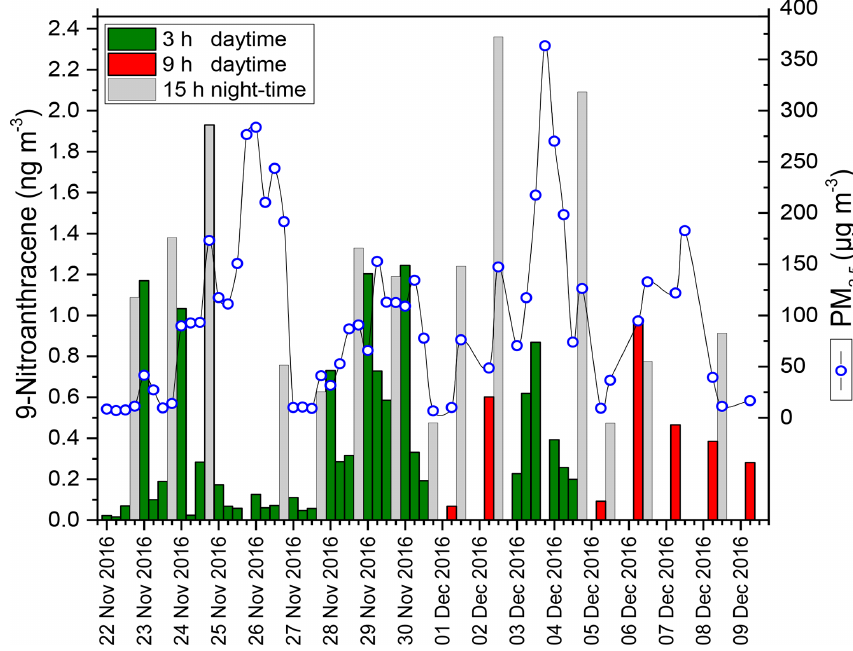
Figure 6. Temporal variation of 9-nitroanthracene and PM 2 . 5 over the entire winter campaign.